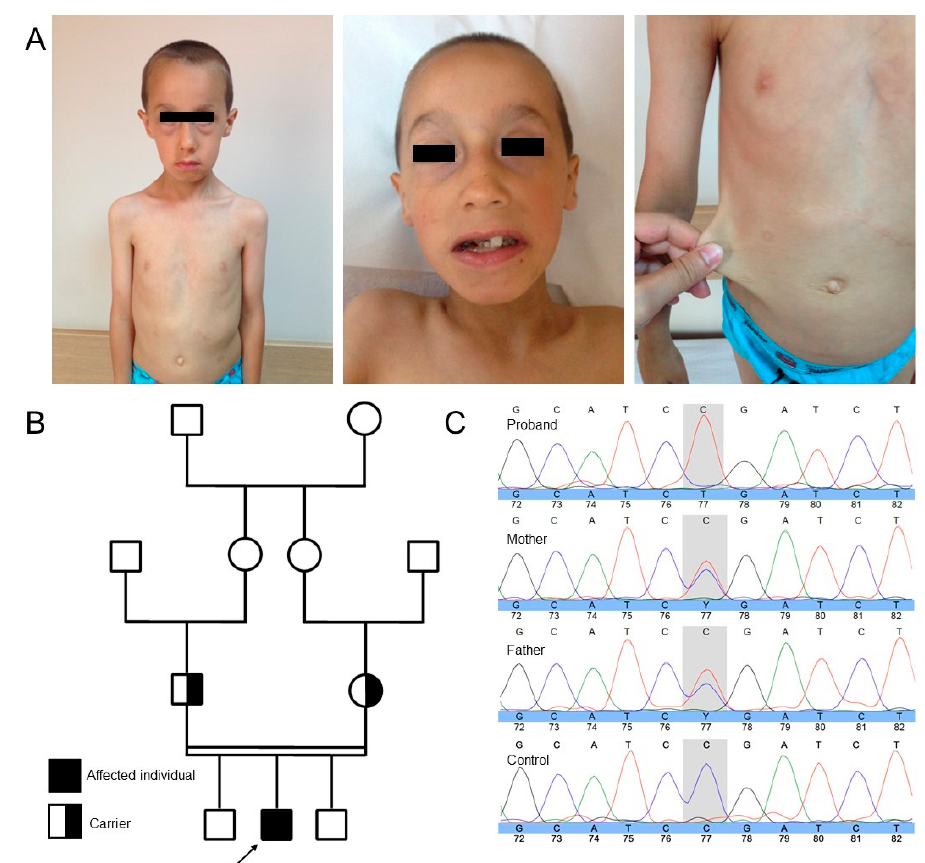
Figure 1. ( A ) Clinical photographs taken at age 7. Note the long face, high anterior hairline, telecanthus, blepharochalasis, sagging lower eyelids and cheeks, long philtrum, full lips, downturned mouth corners, retrognathia, dental caries and malocclusion, and cutis laxa. ( B ) Pedigree of the reported consanguineous family of Turkish descent. The proband is indicated by the black arrow. ( C ) Sanger sequencing confirms the presence of a homozygous EFEMP1 nonsense variant (c.1201C > T, p.(Arg401*)) in the proband and identifies both parents as heterozygous carriers.